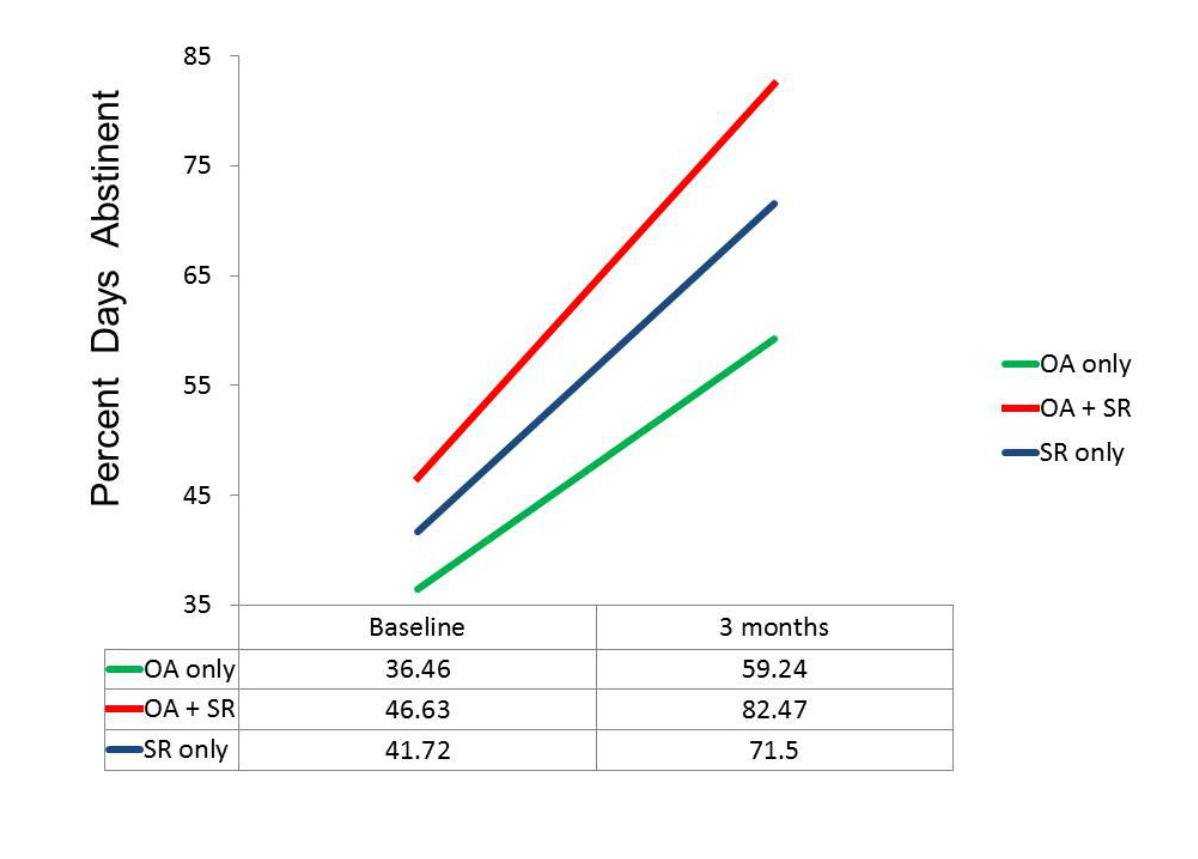
Figure 3. Actual use groups: Percent days abstinent.